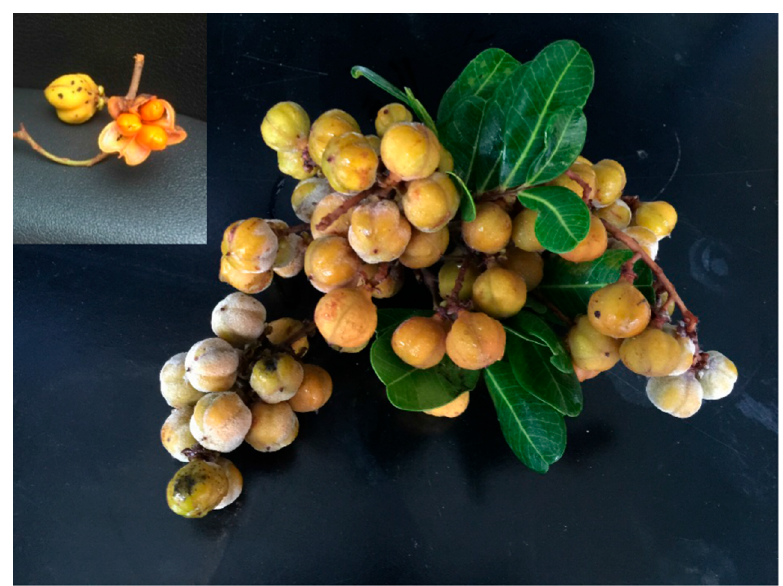
Figure 1. Tuckeroo ( Cupaniopsis anacardioides ) fruits.